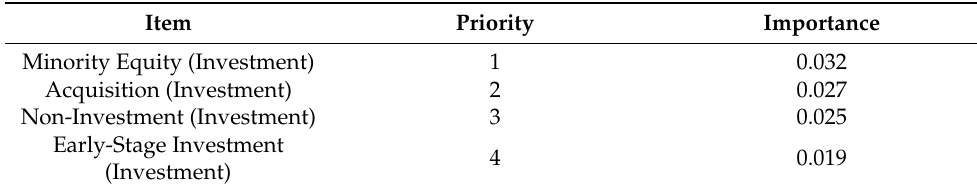
Table 12. Results of investment